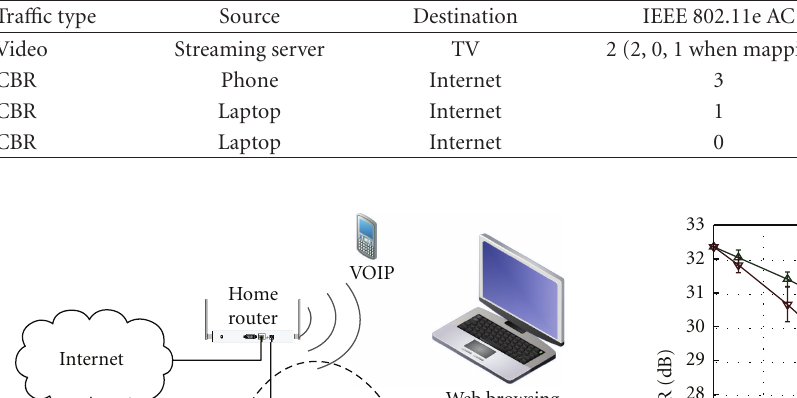
Table 2: Tra ffi c in the scenario of Figure 6.